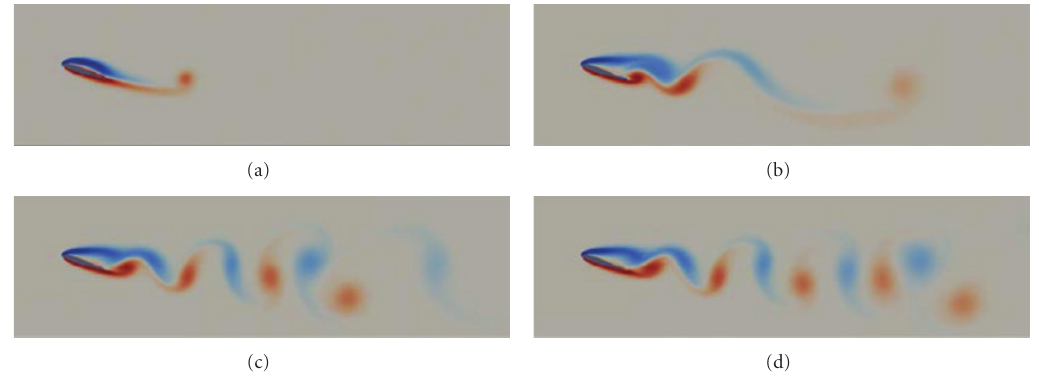
Figure 21: Vorticity plots of Re = 400 when M = 4 for t = 1 . 9 (a), 6.3 (b), 10.7 (c), and 12.9